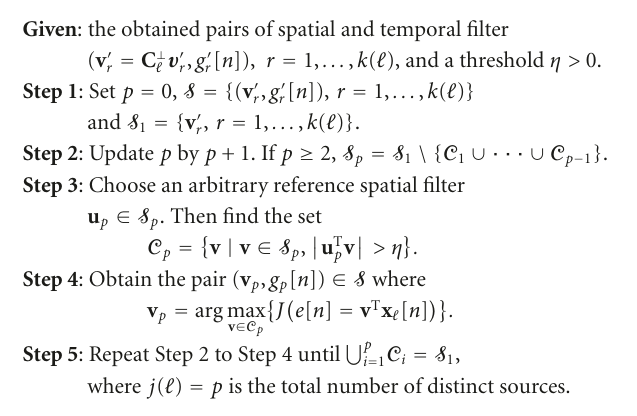
Table 3: Source signal classification algorithm.